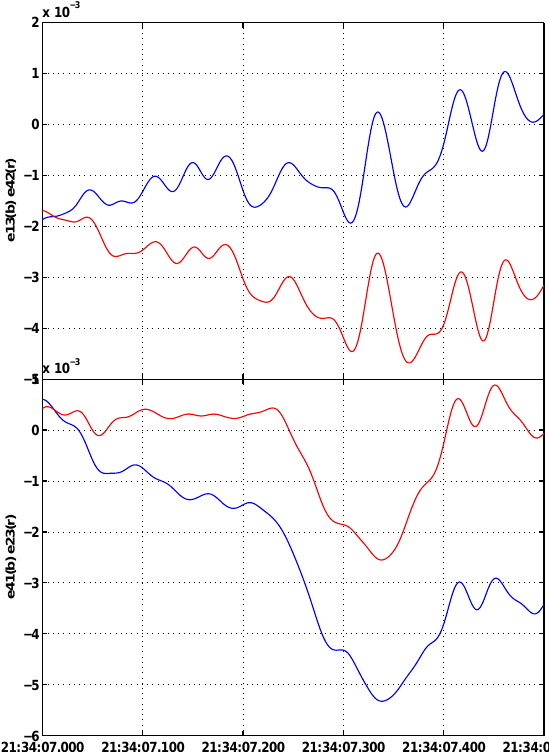
Fig. 13. The electric field waveforms E 13 and E 42 (top panel) and E 41 and E 23 (lower panel) for the third event.